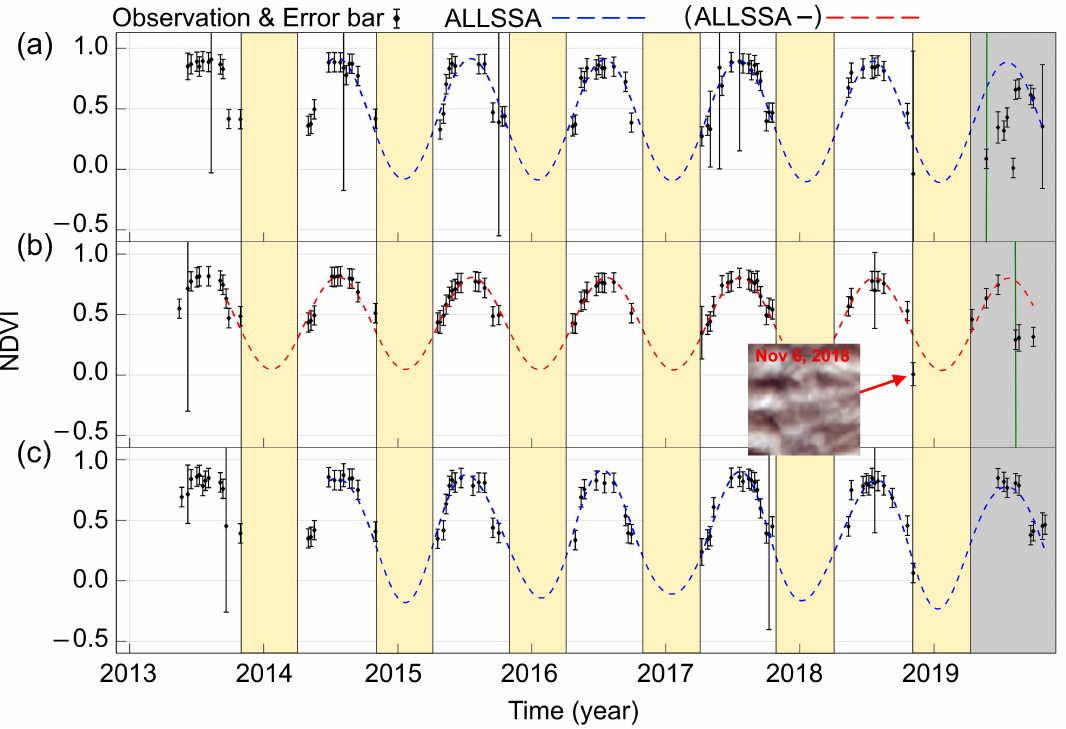
Figure 9. The near-real-time change detection results using NDVI time series corresponding to pixels A, B, and C displayed in Figure 7. The history period is from 2013, and the expected values (forecast) in MP (April–November, 2019; gray background), using the observations in SHP, are shown with blue and red dashed lines. The green vertical lines in panels ( a , b ) show the detected disturbances after one and four observations in MP, respectively. The observational uncertainties are shown by the black bars. The periods with large data gaps have yellow backgrounds. In the legend, “ALLSSA − ” means that SHP in panel ( b ) is determined by ALLSSA after ignoring the observation shown by arrow. A view of the clipped satellite image for pixel B, acquired on the 6 of November 2018, is also shown in panel ( b ). No disturbance is detected during MP in panel ( c